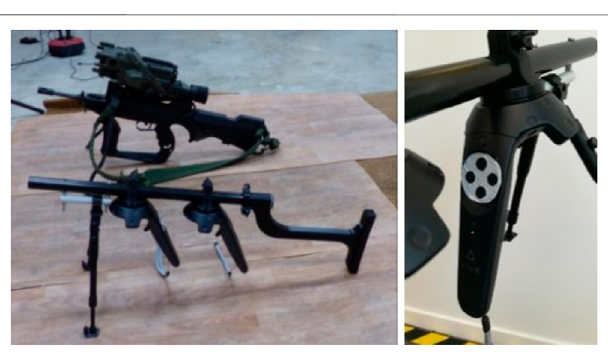
FIGURE 6 | A 3D-printed ri fl e rack to simulate the actual ri fl e feeling for soldiers to practice the FELIN in VR. Image courtesy of Taupiac et al. (2019).